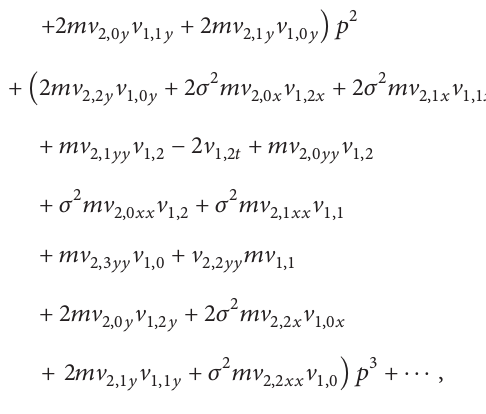
where V (𝑖,𝑗) , 𝑖 = 1, 2, 3, 𝑗 = 0, 1, 2, 3, . . . are functions yet to be determined. Substituting (8) into (6) and arranging the coefficients of 𝑝 powers, we